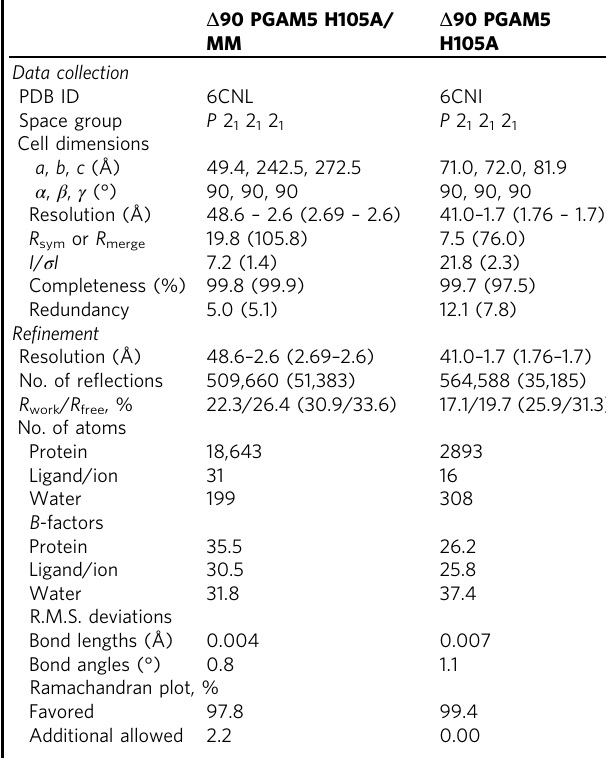
Table 1 Data collection and re fi nement